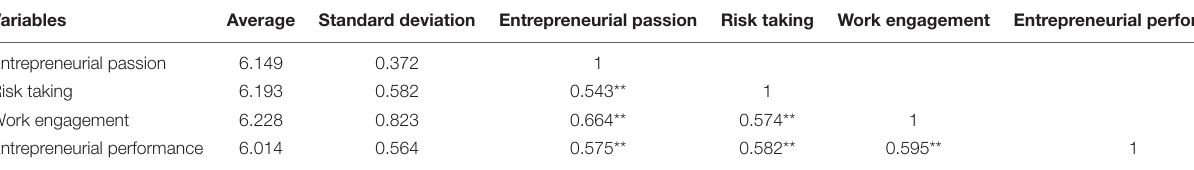
TABLE 3 | Correlation analysis of variables. Variables